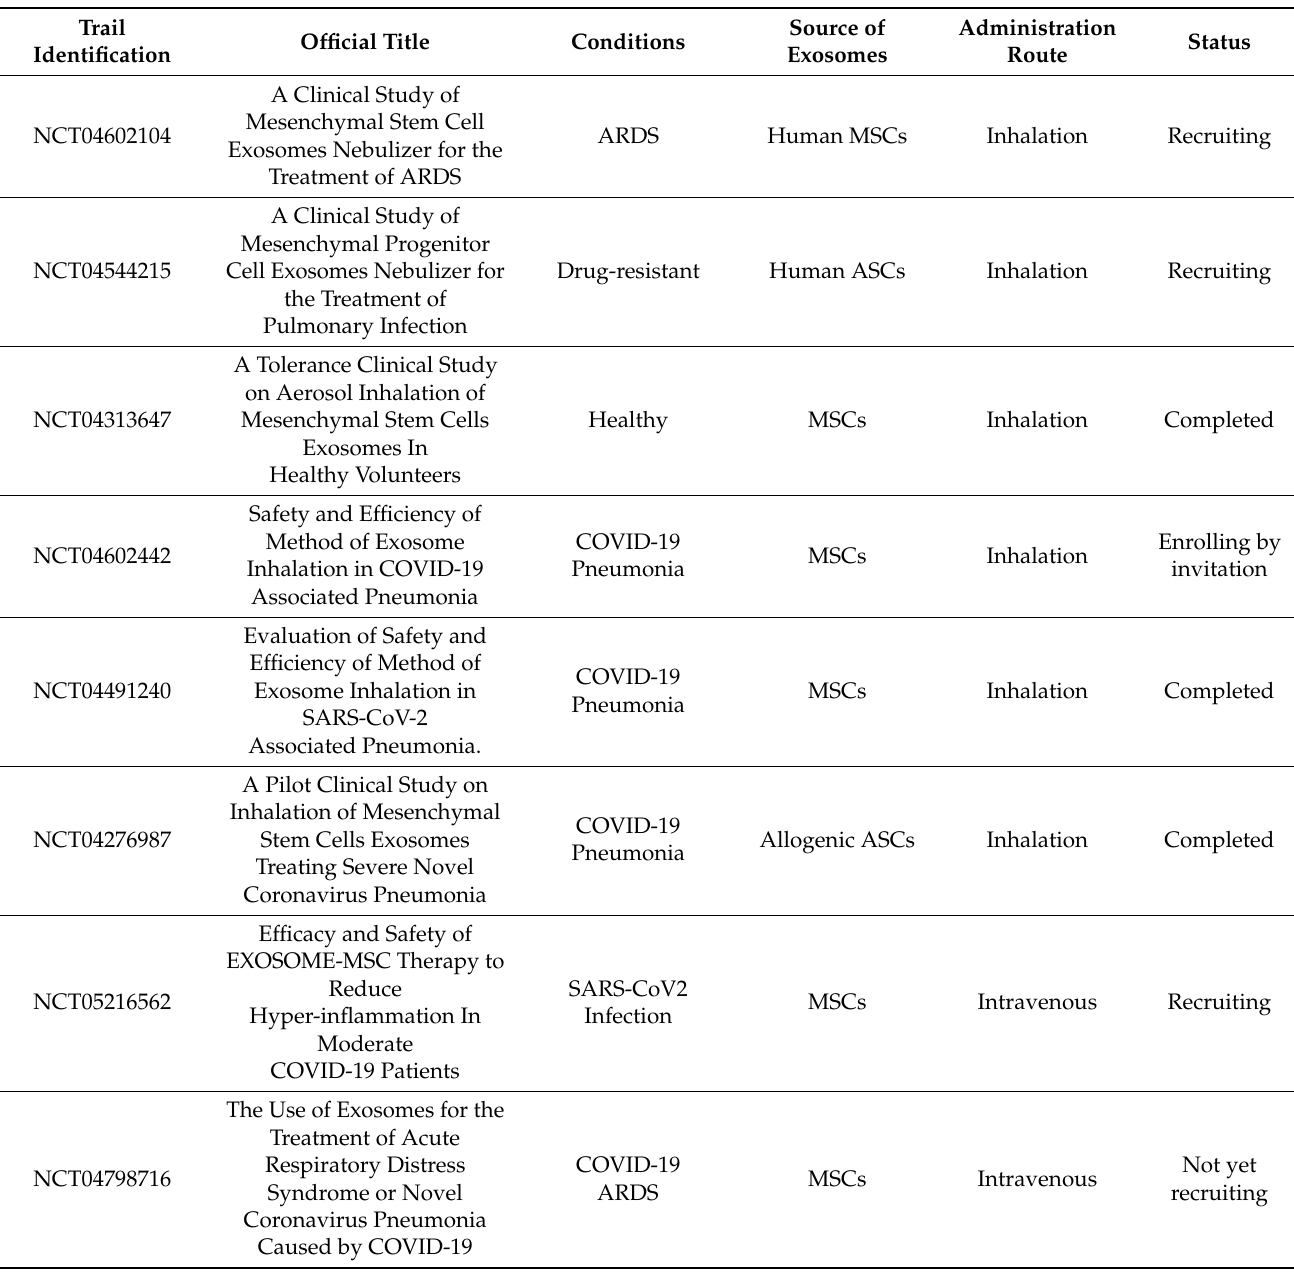
Table 3. Clinical trials conducted with SC-Exos on patients with respiratory diseases (www. clinicaltrials.gov; accessed on 20 April